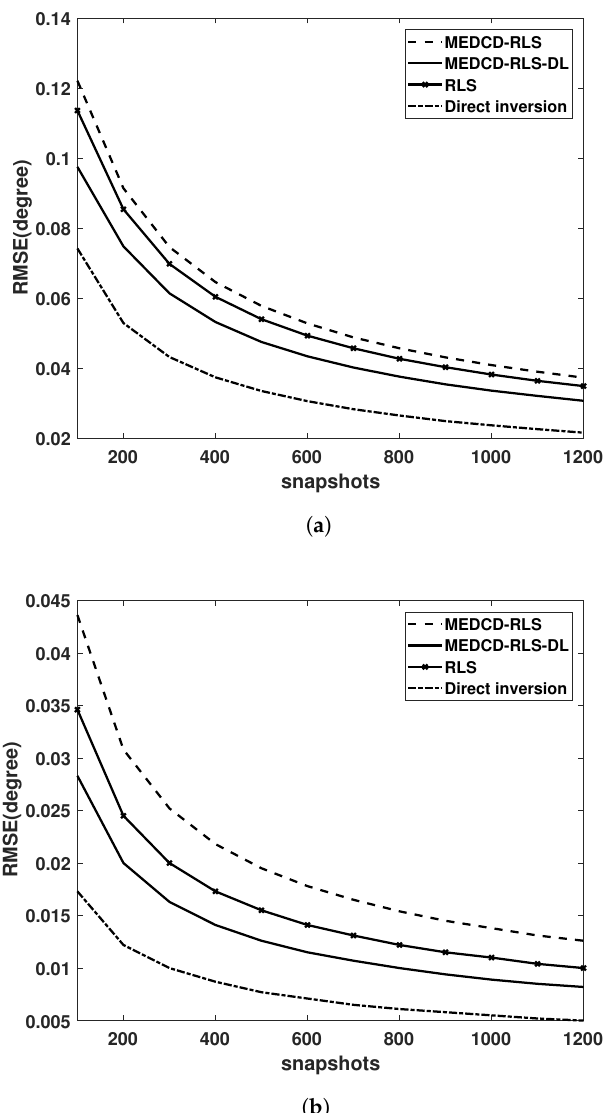
Figure 2. RMSE vs. snapshots with different SNRs; θ true = 50.6 ◦ . ( a ) SNR = 10 dB. ( b ) SNR = 20